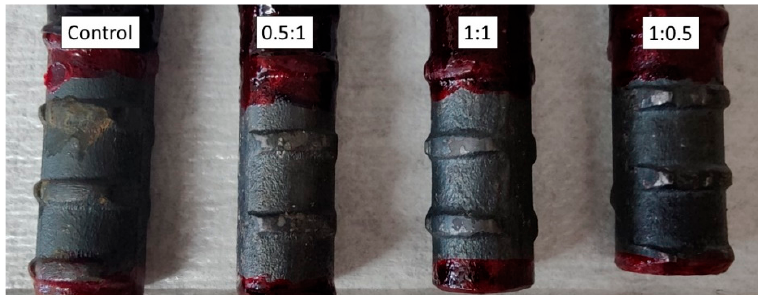
Figure 7. Photographs of the rebars after exposure to SCPS with 0.6 M NaCl and inhibitor blends of 0.5:1, 1:1, and 1:0.5 NaNO 2 :NaNO 3 at 45 °C.